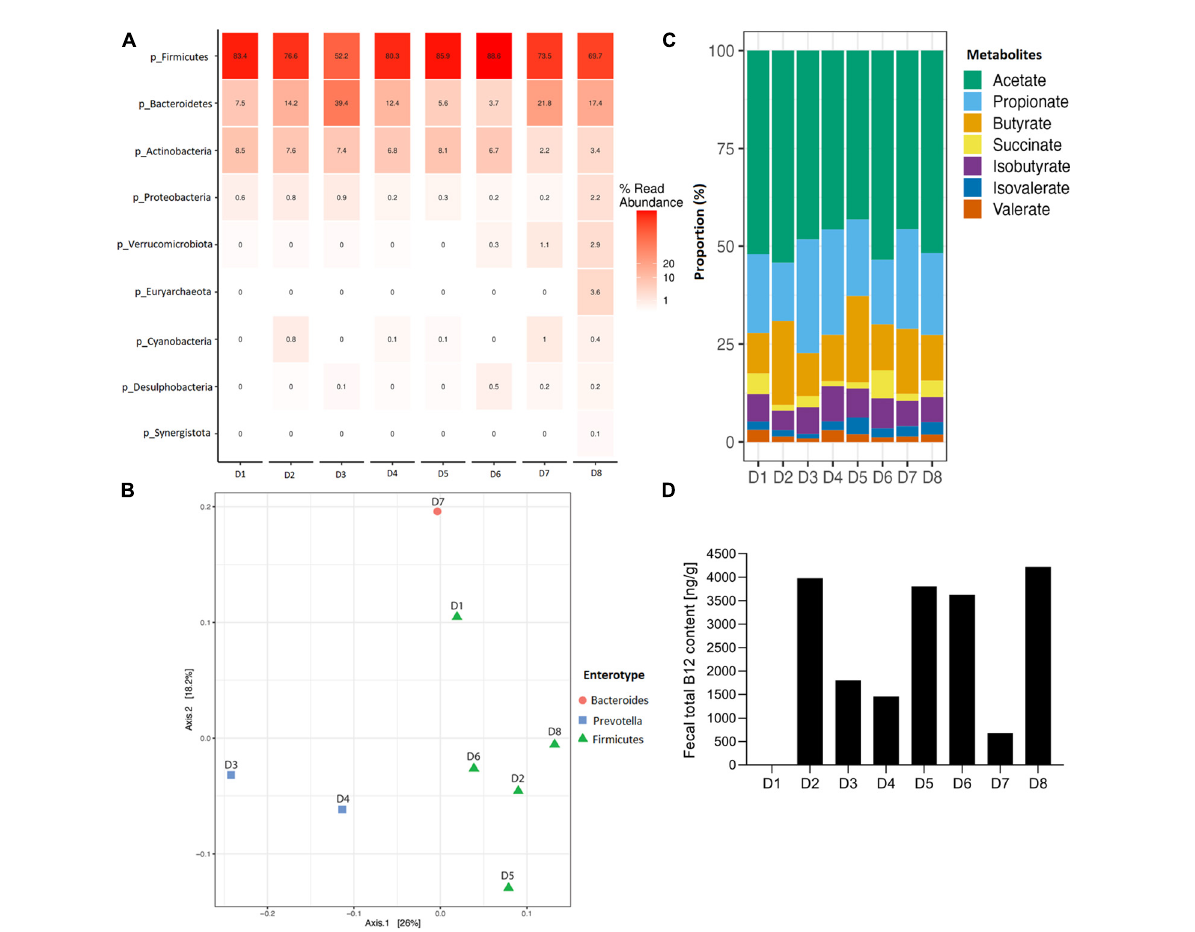
FIGURE1 Fecal microbial composition, enterotype clustering, metabolite profile and total B12 content of eight fecal donors (D1 to D8) used in this study before fermentation. (A) Relative abundance of fecal microbial communities of each donor at phylum level. (B) Donors colored by the enterotype they belong to, with red enterotype 1 ( Bacteroides ), blue enterotype 2 ( Prevotella ) and green enterotype 3 ( Firmicutes ), and clustered with Jensen-Shannon divergence distance matrix. (C) Metabolite proportion of each donor. For all donors, lactate and formate were below detection limit, therefore, not shown in the plot. (D) Fecal total B12 content (ng/g feces), B12 content for D1 was below detection limit (i.e., 30